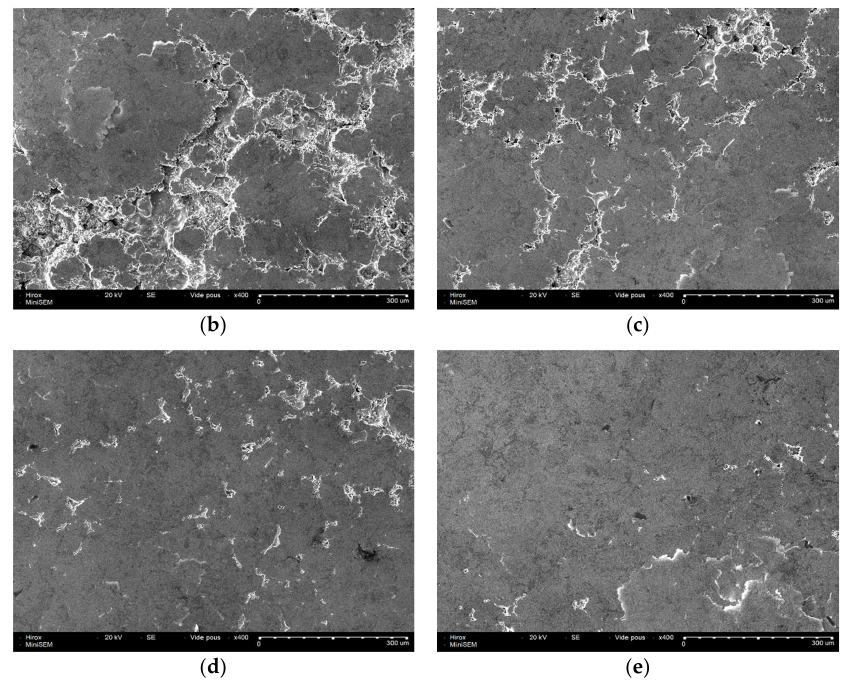
Figure 1. SEM micrographs of coatings’ surfaces: ( a ) Untreated Ni–Cr; ( b ) SMATed with an amplitude of 15 µm for 405 s; ( c ) SMATed with an amplitude of 15 µm for 810 s; ( d ) SMATed with an amplitude of 25 µm for 400 s; ( e ) SMATed with an amplitude of 25 µm for 800 s. Cross sections of the as-sprayed and SMATed coatings corresponding to various parameters are shown in Figure 2. It is shown that the as-deposited coatings had a lamellar structure containing pores and interlamellar cracks. The formation of interlamellar cracks was due to the thermal stress caused by rapid solidification. After SMAT, the coatings were more compact, without defects or cracks.